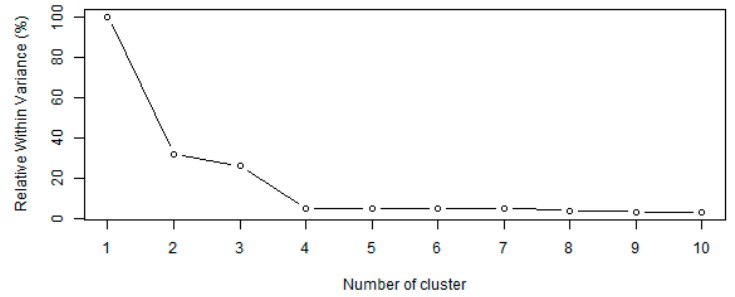
Figure 4. Relative within variance for each number of clusters.